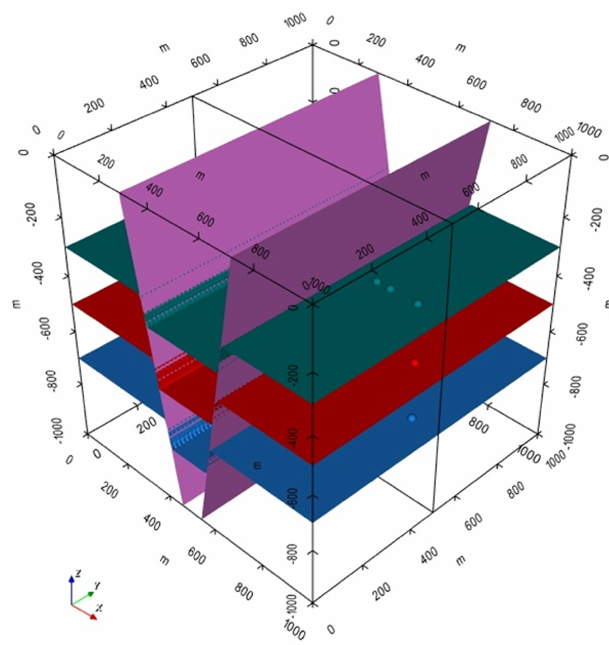
Figure 8. Structural data for the graben model and modeled surfaces for units and faults. Spheres represent interfaces and cones represent pole